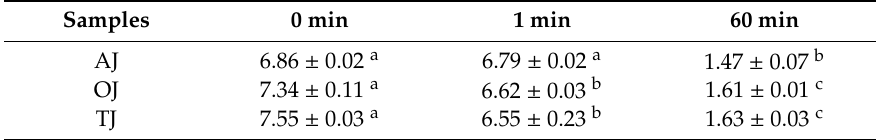
Table 1. The change of viability of probiotics in fruit and vegetable juice samples in the digestion of simulated gastric juice (pH = 2).